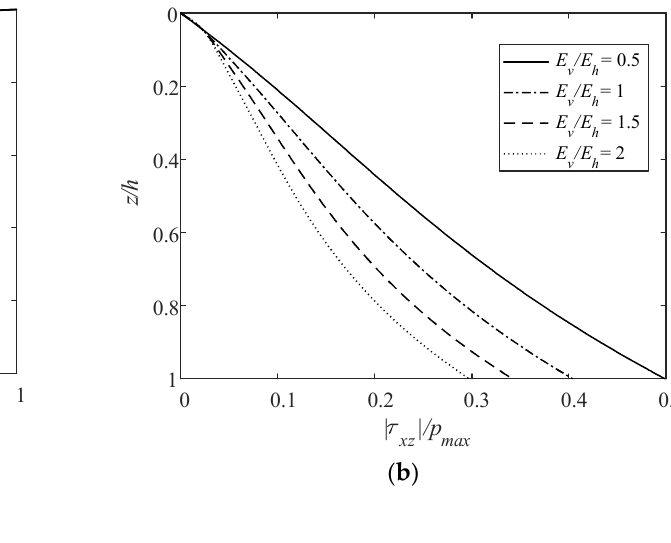
Figure 10. Maximum liquefaction depth z max versus K v / K h for various ( a ) degrees of saturation, ( b ) wave periods, ( c ) soil porosities, and ( d ) current velocities. The effects of E v /E h on the vertical distributions of normalized | p| , | τ xz |, | σ (cid:48) zz | and | σ (cid:48) xx | are also studied, as shown in Figure 11. Here, E h = 2.6 × 10 7 Pa, while E v varies. Unlike K v / K h , E v /E h affects not only the vertical distributions of all | p| , | σ (cid:48) zz | , and | σ (cid:48) xx | but also | τ xz |. However, with the increase in E v /E h (from 0.5 to 2), the normalized | p| , | τ xz |, and | σ (cid:48) xx | at the same depth all basically decrease, while | σ (cid:48) zz | increases. Meanwhile, the influences of E v /E h on the normalized | p| , | τ xz |, | σ (cid:48) zz | and | σ (cid:48) xx | all decay with the increase in E v /E h . Figure 12 denotes z max versus E v / E h for various S r , T , n , and U 0 . On the contrary to the effect of K v / K h , z max increases with E v / E h , showing the tendency of more severe liquefaction. For the same E v / E h , z max increases with decreasing S r and T but increasing n . Similar to the effect of K v / K h , the following current aggravates the liquefaction depth whilst the opposing current alleviates the liquefaction depth. It is obvious that even though | U 0 | is equal, the direction of the current can lead to varying degrees of change in z max . Besides, if the seabed is regarded as isotropic, z max would be underestimated when E v / E h > 1 but overestimated when E v / E h < 1.